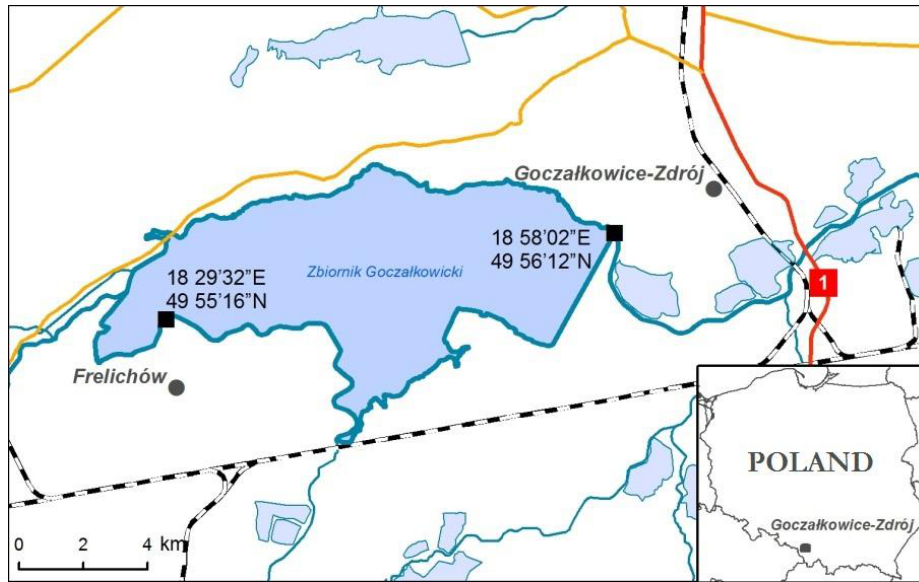
Fig. 1. Location of the measurement points in Goczałkowice and Frelichów